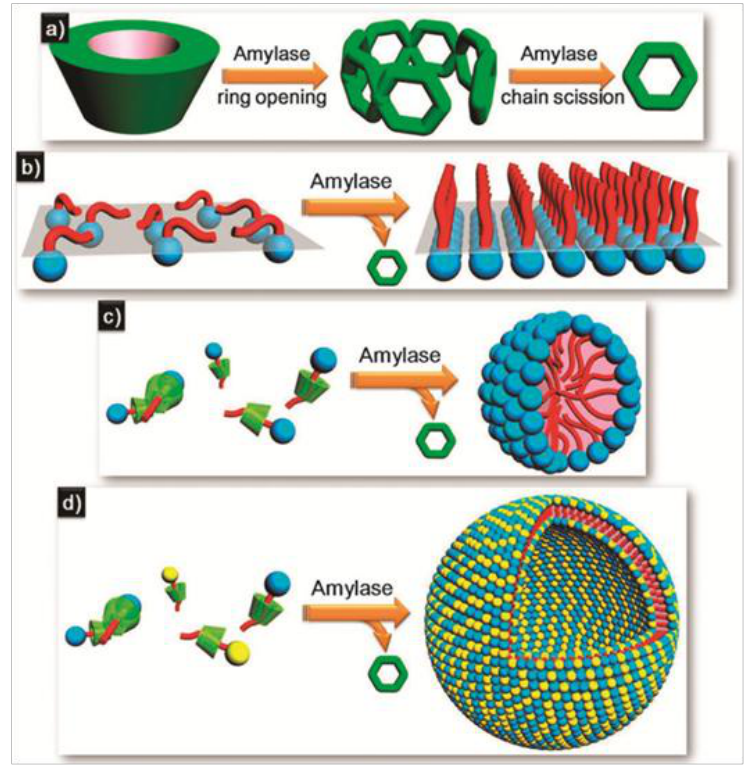
Figure 9. Schematic illustrations of the degradation of β-CD by α-amylase ( a ); enzyme-triggered monolayer formation ( b ); enzyme-triggered micellization ( c ); and enzyme-triggered vesicle formation ( d ). Reproduced with permission from [46]. Copyright 2012 The Royal Society of